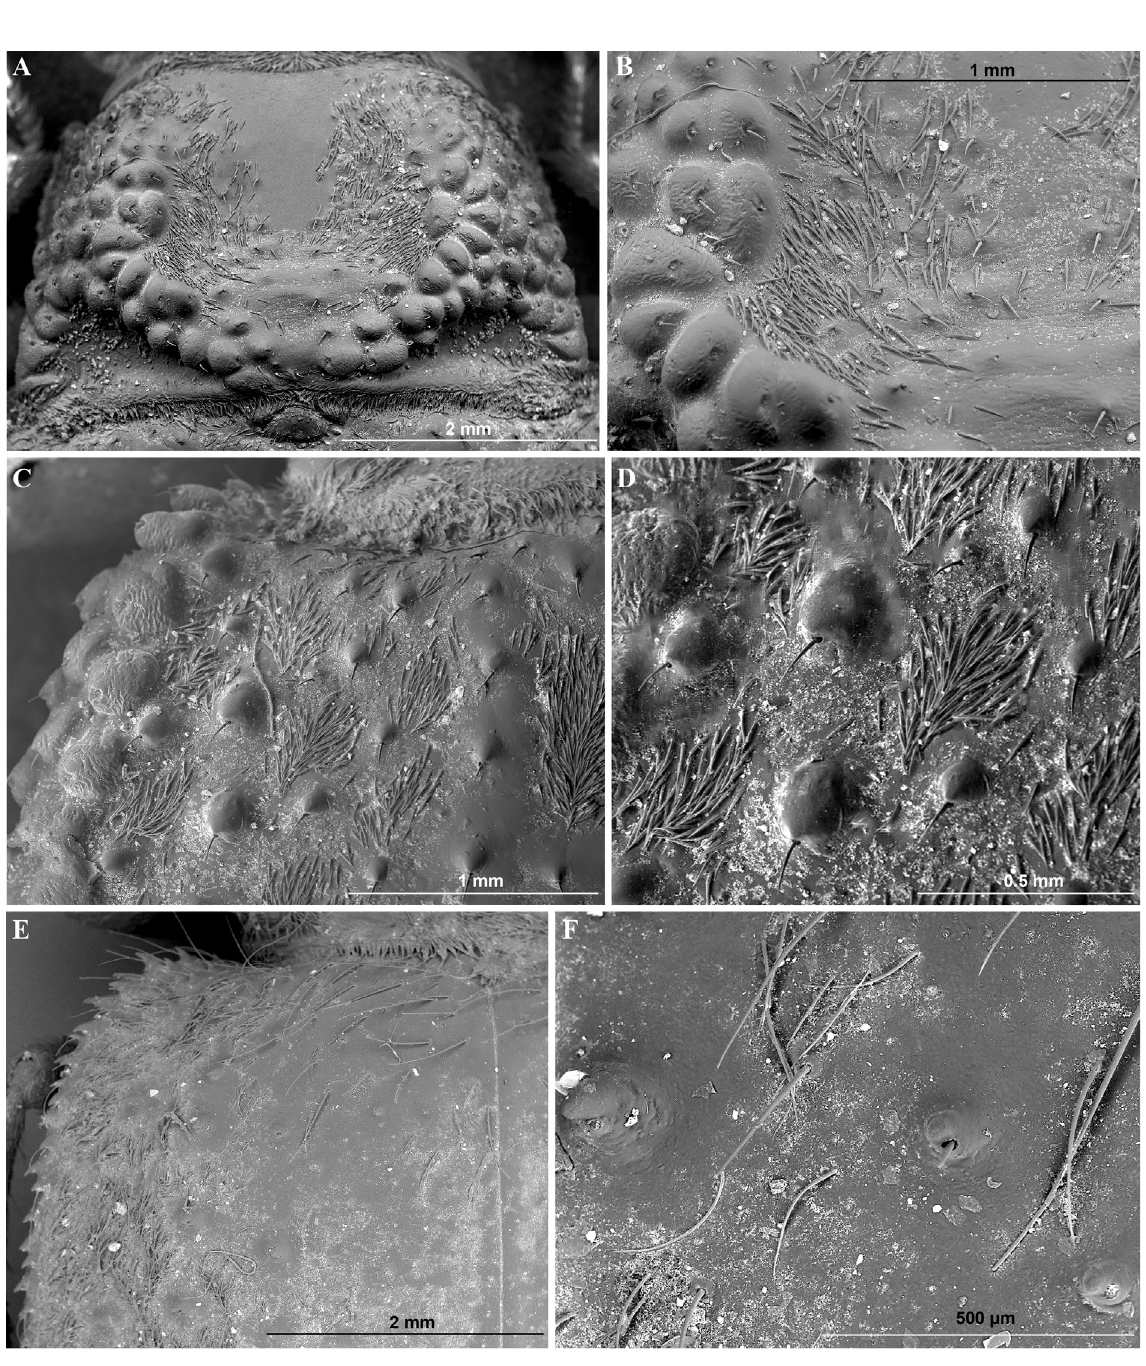
Fig. 13. Platyope Fischer von Waldheim, 1820 and Earophanta Semenov, 1903, details of structure. A . P. grumi (Semenov, 1893), paralectotype (ZIN), pronotum. B . Ditto, hemispherical large tubercles and pubescence of pronotum. C . Ditto, base of left elytron. D . Ditto, tubercles and setae on elytron. E . E. serrata (Semenov, 1893) (ZIN), basal half of left elytron. F . Ditto, sculpture and setation of